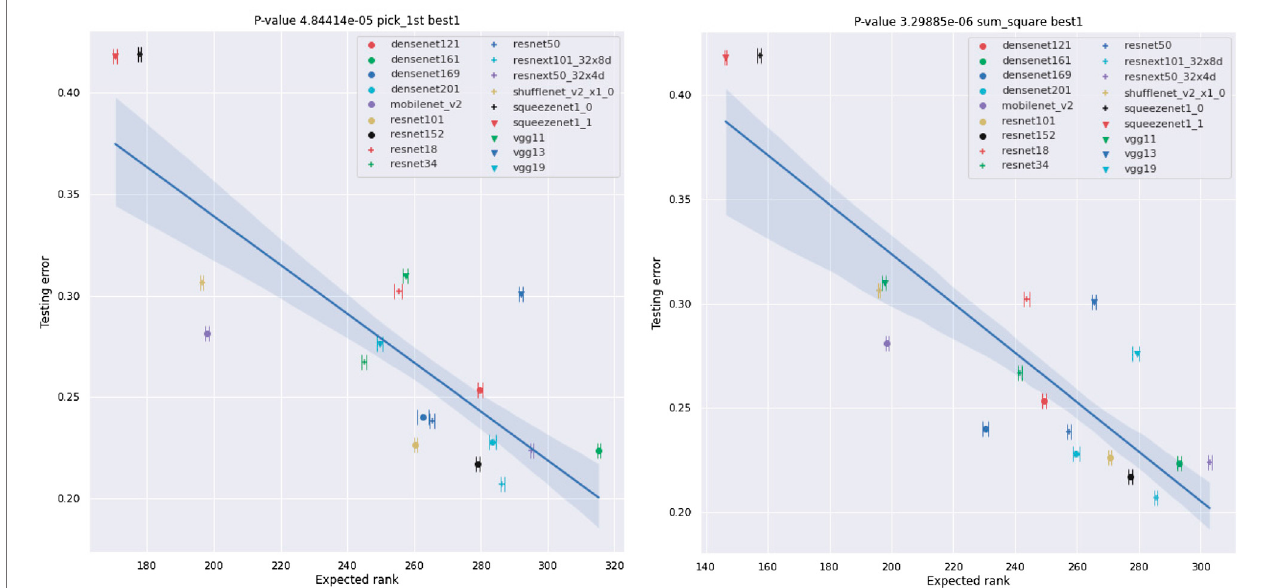
FIGURE 9 | Plots of the best-1 testing error of NNs against their ESD. The testing errors are as provided by [30] and are error rates for testing on ImageNet crop images.WealsoprovidetherangeoftheESDover10differentexperimentsusingsyntheticdataoftheform x ∈ {− 1 , 1 } 3 × 224 × 224 ,and,ascanbeobserved,therangesare quite small relative to the differences between the various networks. In addition, the ESD shows a strong negative correlation with the best-1 error. The con fi dence bounds on the linear fi t are one- σ bounds based on 1,000 bootstrap samples.